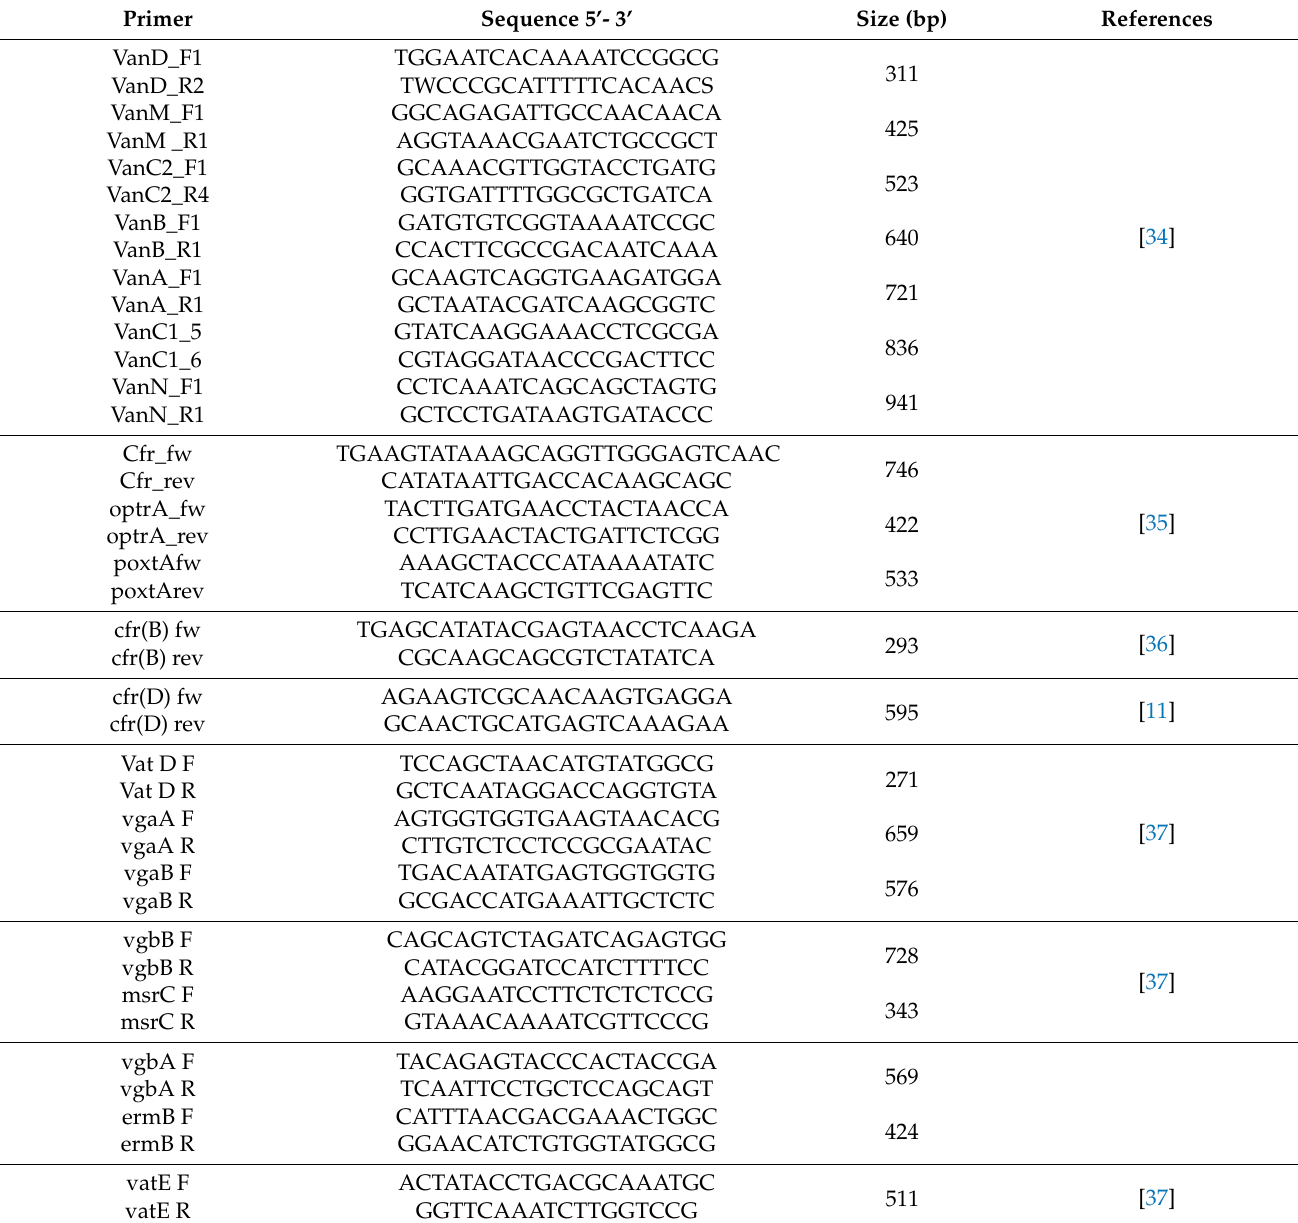
Table 3. Details of single and multiplex PCR protocols applied for antibiotic resistance and virulence gene